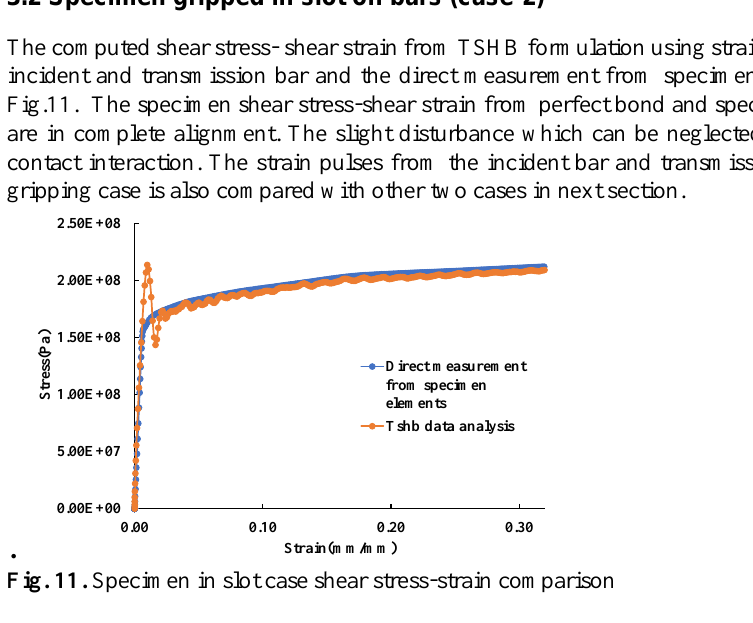
Fig. 11. Specimen in slot case shear stress-strain comparison